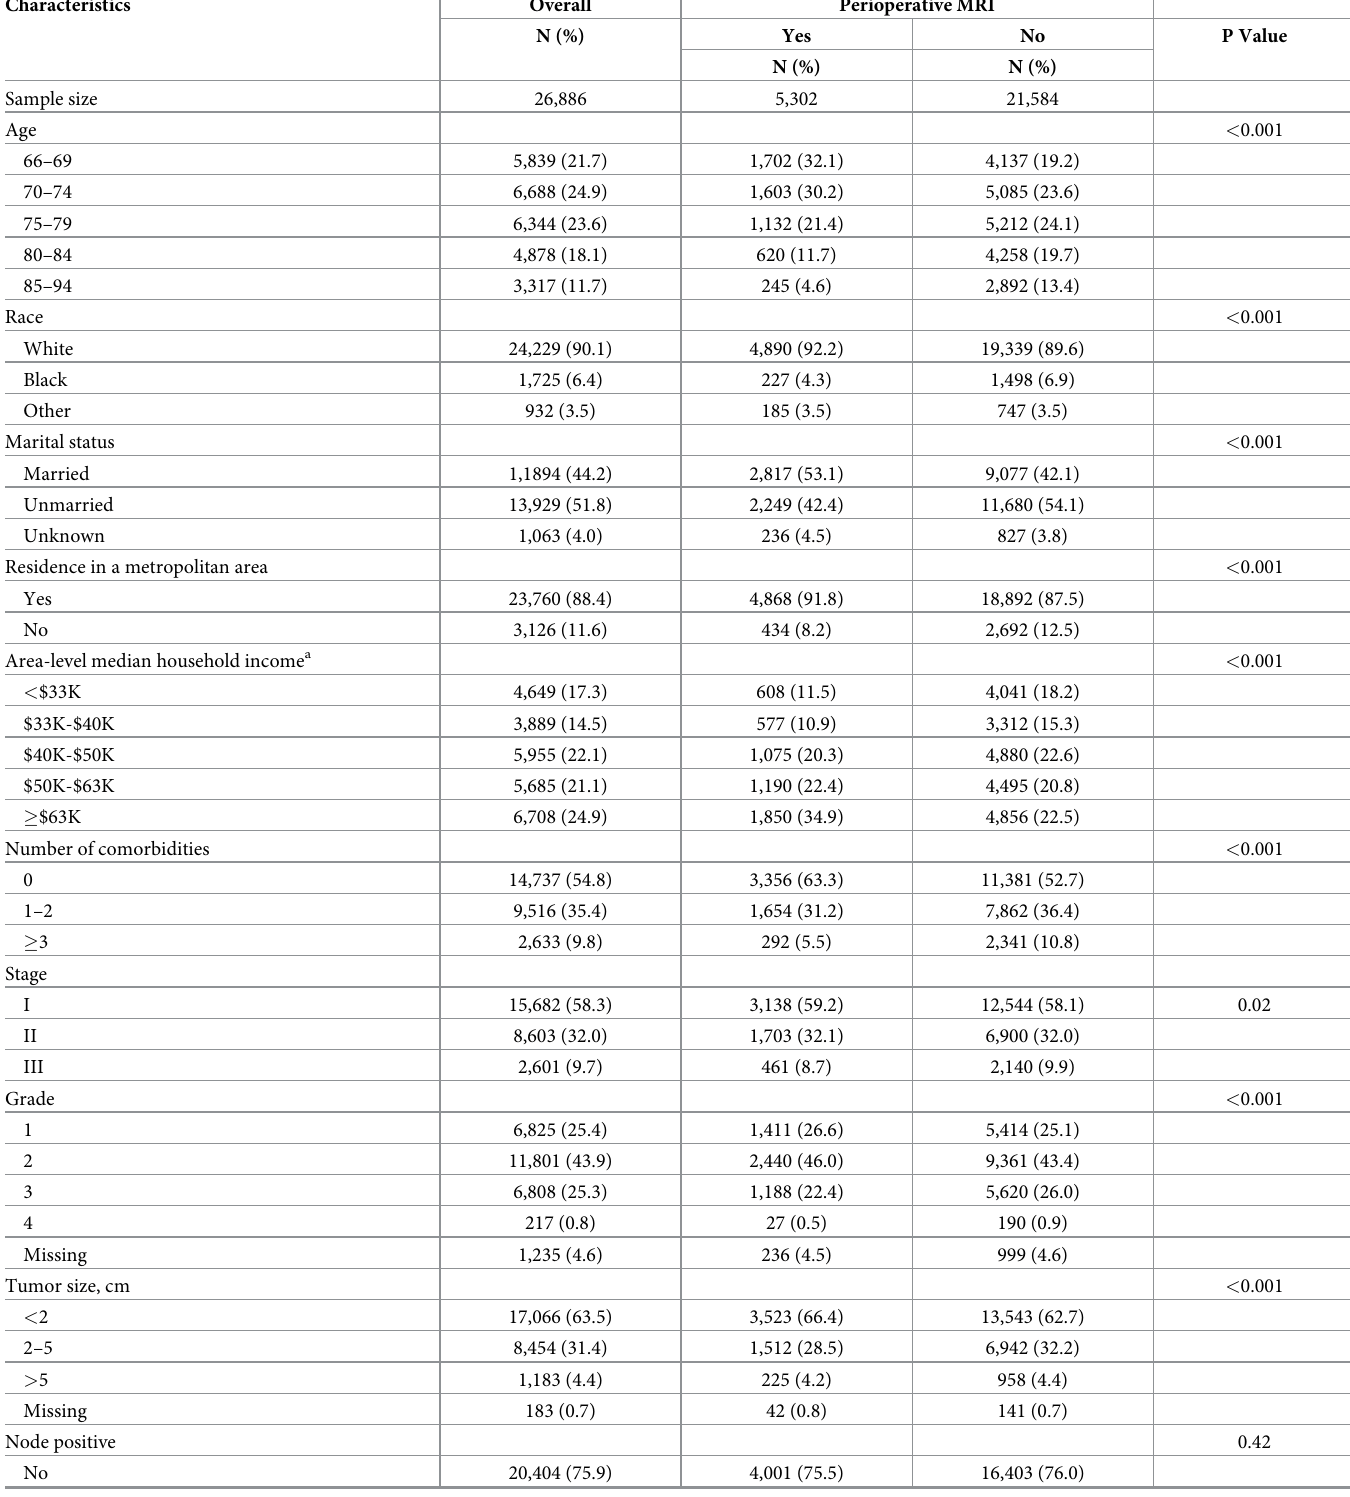
Table 1. Characteristics of patients in the breast cancer sample (N = 26,886 patients).